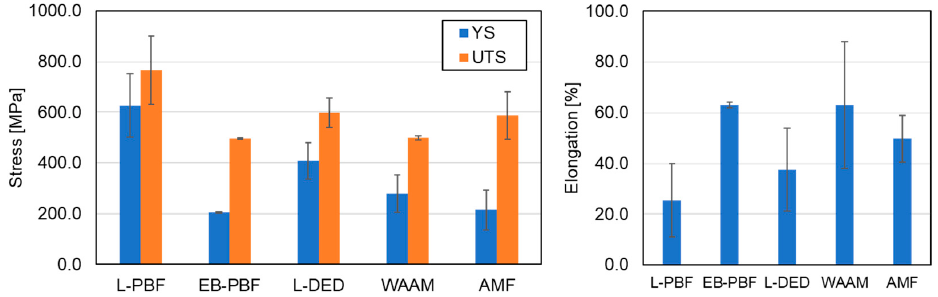
Figure 18. The e ff ect of di ff erent AM technologies on tensile strength of CrMnFeCoNi HEA in terms of YS, UTS, and elongation. L-PBF [45,74,75,82,84,87,203], EB-PBF [115], L-DED [160,168,170–174,180], WAAM [202], AMF [87,172,246].